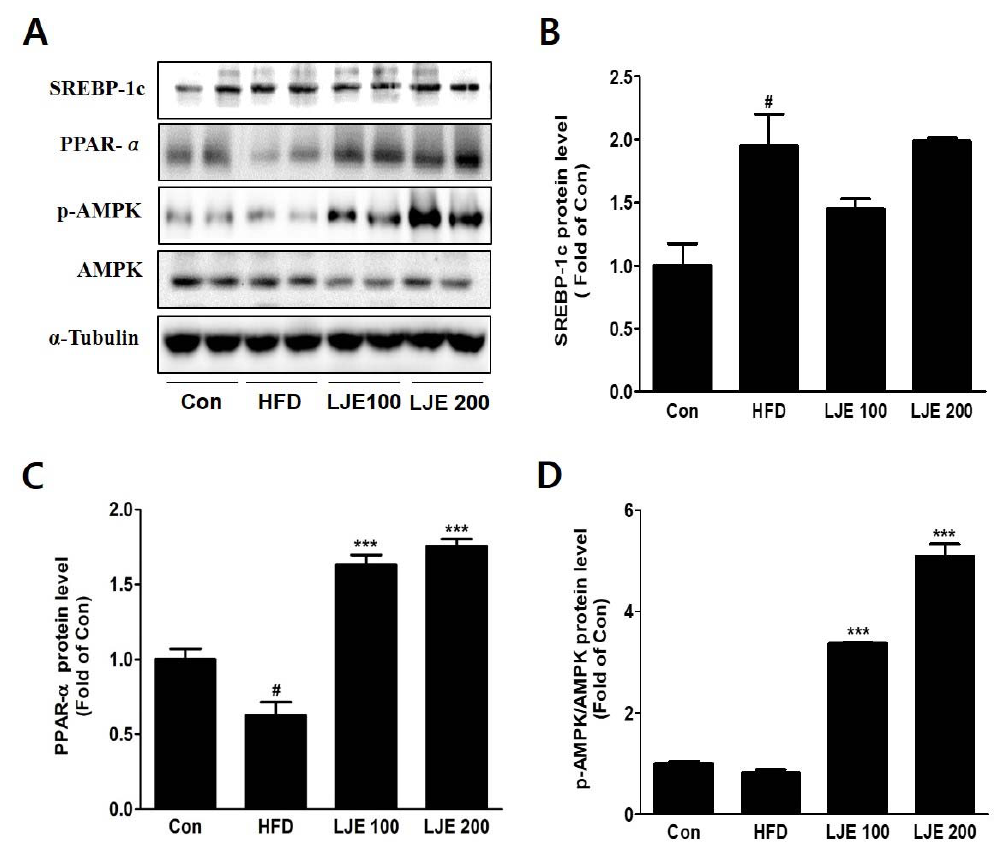
Figure 8. Effects of LJE on hepatic lipid metabolism in HFD-fed mice. ( A-D ) SREBP-1, PPAR- α , and phosphorylated AMPK protein levels by immunoblot analysis. Con, normal control diet; HFD, high-fat diet; LJE 100, HFD plus LJE (100 mg/kg, peroral); LJE 200, HFD plus LJE (200 mg/kg, peroral). Data represent means ± SEM ( n = 8). # p < 0.05 vs. Con; *** p < 0.001 vs. HFD.